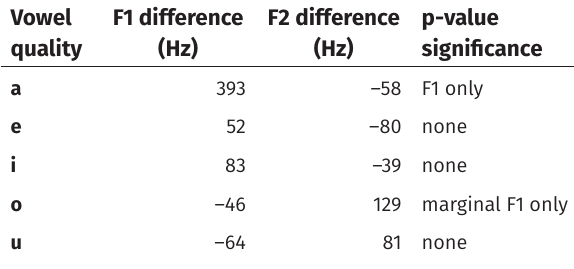
Table 5: Formant differences and p-values for oral-nasal vowel differences.